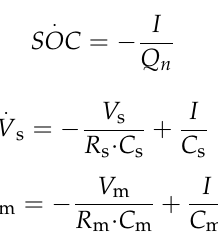
Figure 2. Open circuit voltage (OCV)–state of charge (SOC) curve.